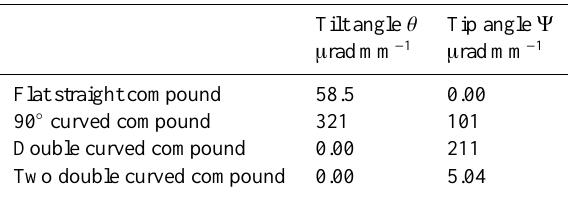
Table 1. Main stage tip and tilt angle in microradians per millimeter of z-axis displacement for the di ff erent compound-spring iterations (flexure length is constant for all iterations).